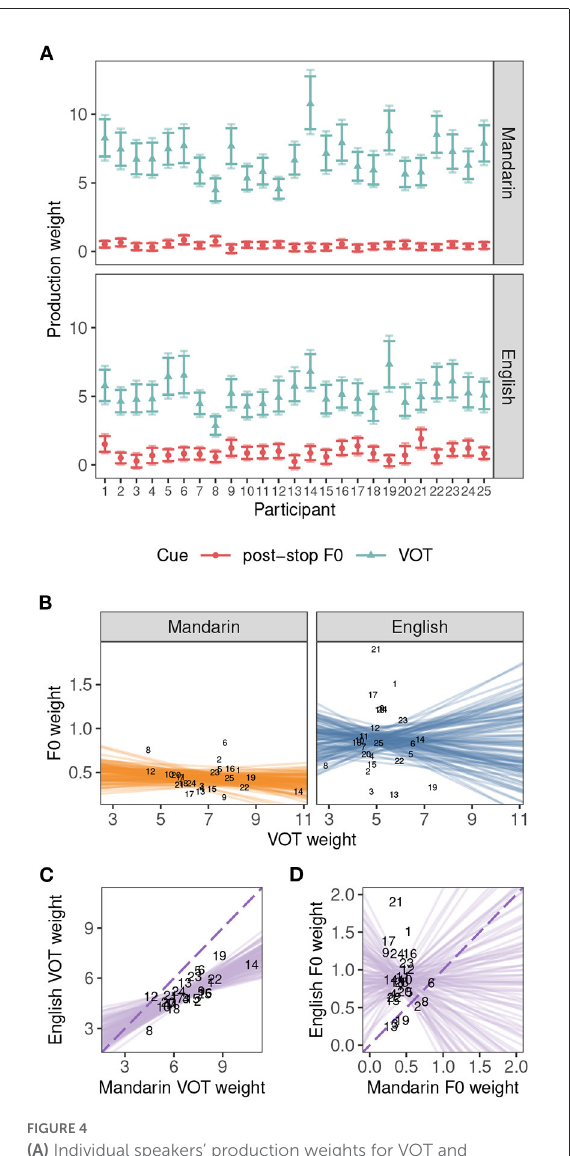
FIGURE4 (A) Individual speakers’ production weights for VOT and post-stop F0. The posterior means are represented by the dots. The 89% CrIs are represented by the inner error bars, and the 95% CrIs are represented by the outer error bars. (B) Post-stop F0 weights against VOT weights, separately for each language. (C) Production VOT weights across languages. (D) Production post-stop F0 weights across languages. In (B–D) , the solid lines represent 100 regression lines fitted with 100 posterior draws, to show the direction and uncertainty of the correlation. The dashed line is y = x , where the Mandarin weight equals the English